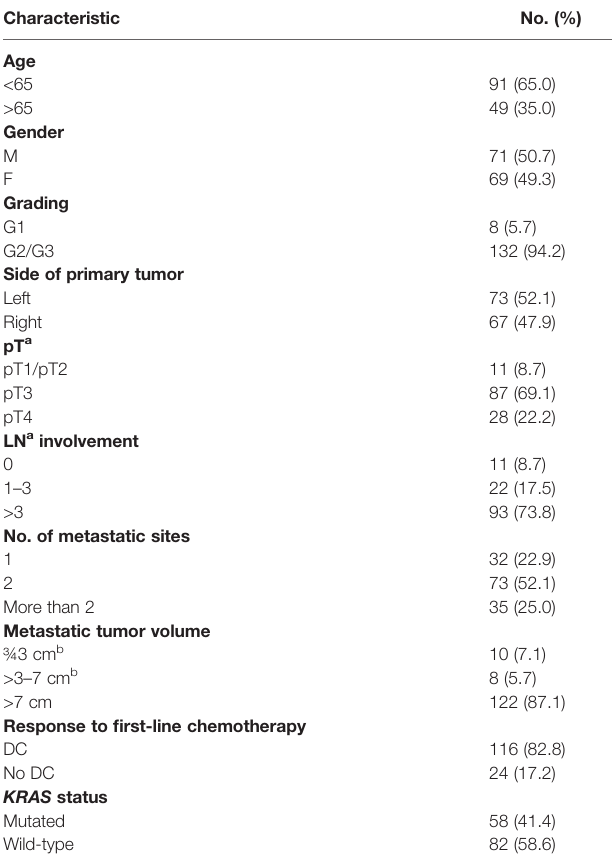
TABLE 1 | Clinicopathological characteristics of metastatic CRC patients ’ cohort.